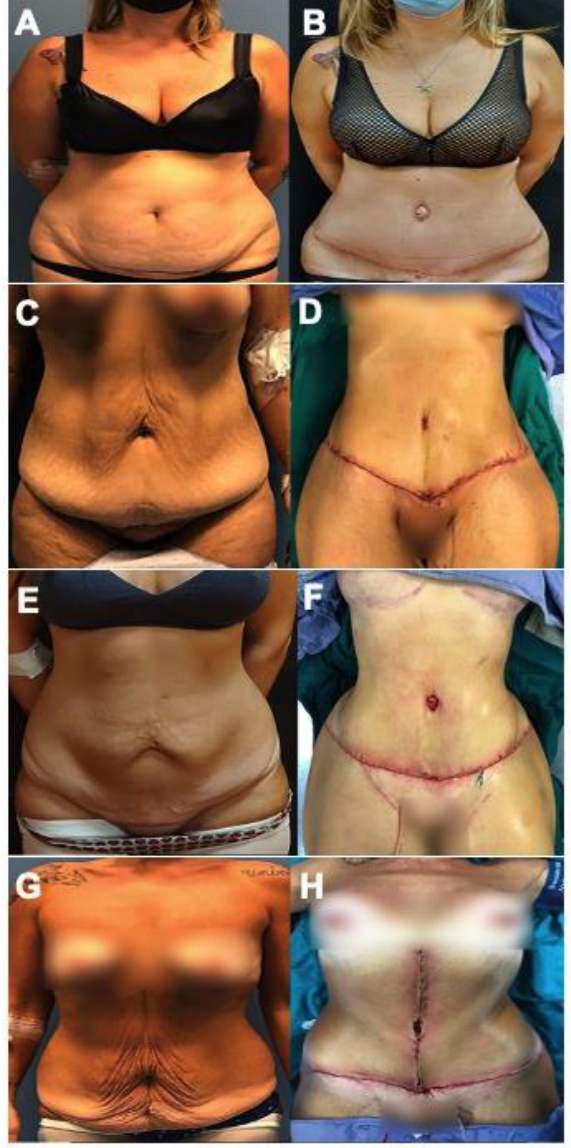
Figure 1. Anteroposterior (AP) view: before ( A , C , E , G ) and after ( B , D , F , H ) the patients underwent abdominoplasty. ( A , B ): Female, 43 years old, underwent traditional abdominoplasty after sleeve gastrectomy and 18 kg of weight loss. ( C , D ): Female, 36 years old, abdominoplasty after gastric mini-bypass and 36 kg of weight loss. ( E , F ): Female, 32 years old, abdominoplasty after sleeve- gastrectomy and 28 kg of weight loss. ( G , H ): Female, 52 years old, abdominoplasty with vertical scar after sleeve-gastrectomy and 43 kg of weight